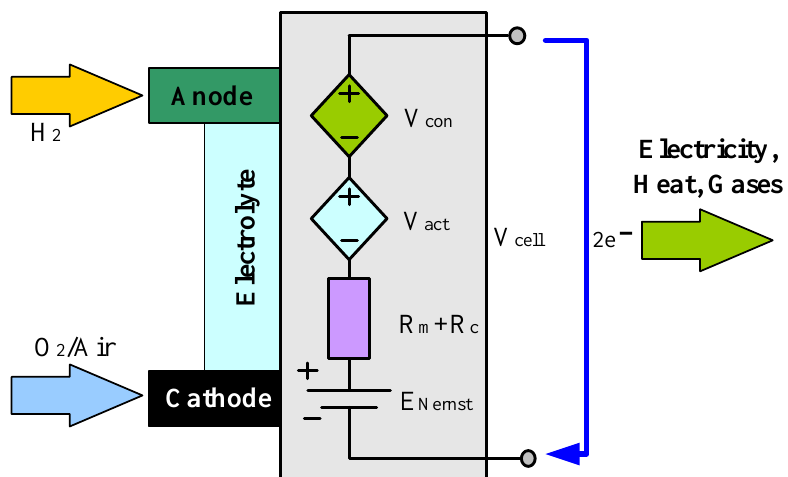
Figure 2. Electrical model of a PEM fuel